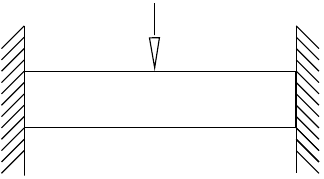
Figure 11. Cantilever beam clamped at both ends loaded in the